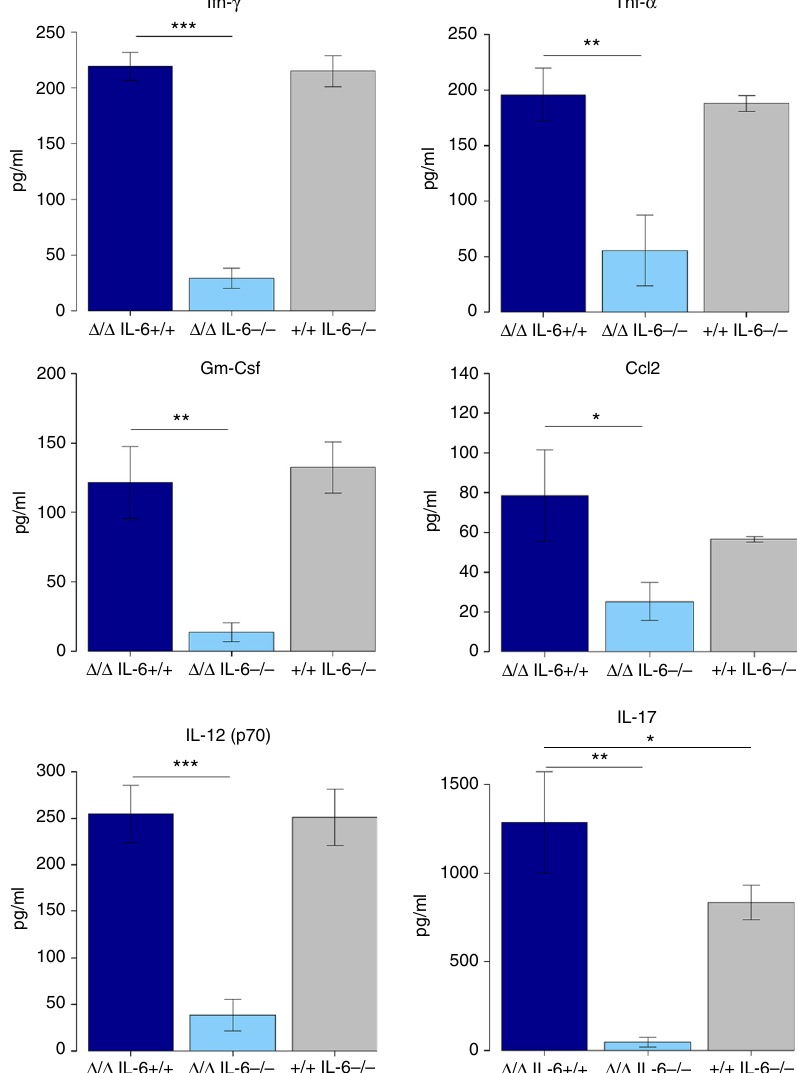
Fig. 1 Reduced expression of pro-in fl ammatory cytokines in IL-6 -de fi cient Δ 122p53 mice. Serum from Δ 122/ Δ 122 IL-6 + / + ( n = 3), Δ 122/ Δ 122 IL-6 − / − ( n = 3) and +/+ IL-6 − / − ( n = 3) mice was analysed using Bio-Plex Pro Mouse Cytokine 23-plex Array. Cytokine concentrations (pg/ml) are means ± s.e. m. Heteroscedastic one-tailed unpaired t -test was performed and p < 0.05 was considered signi fi cant. * p < 0.05, ** p < 0.005 and *** p < 0.0005 are designated, respectively. Δ / Δ = Δ 122/ Δ